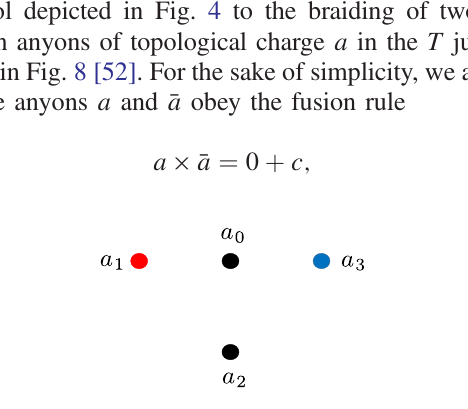
FIG. 8. In the T junction shown here, anyons a 1 , a 2 , and a 3 have topological charge a , and anyon a 0 has topological charge ¯ a . Similar to the protocol for braiding MZMs, at times t ¼ 0 and t ¼ t , anyons a 0 and a 2 (both in black) form the ancillary pair op of anyons. We exchange the positions of the red and blue anyons using a protocol identical to that shown in Fig. 4, with the labels